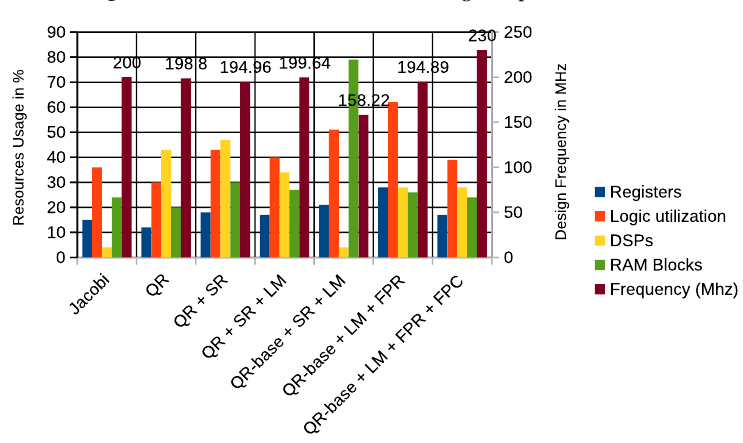
Figure 5. Arria 10 field-programmable gate array (FPGA) resources usage and maximum clock frequency of each design